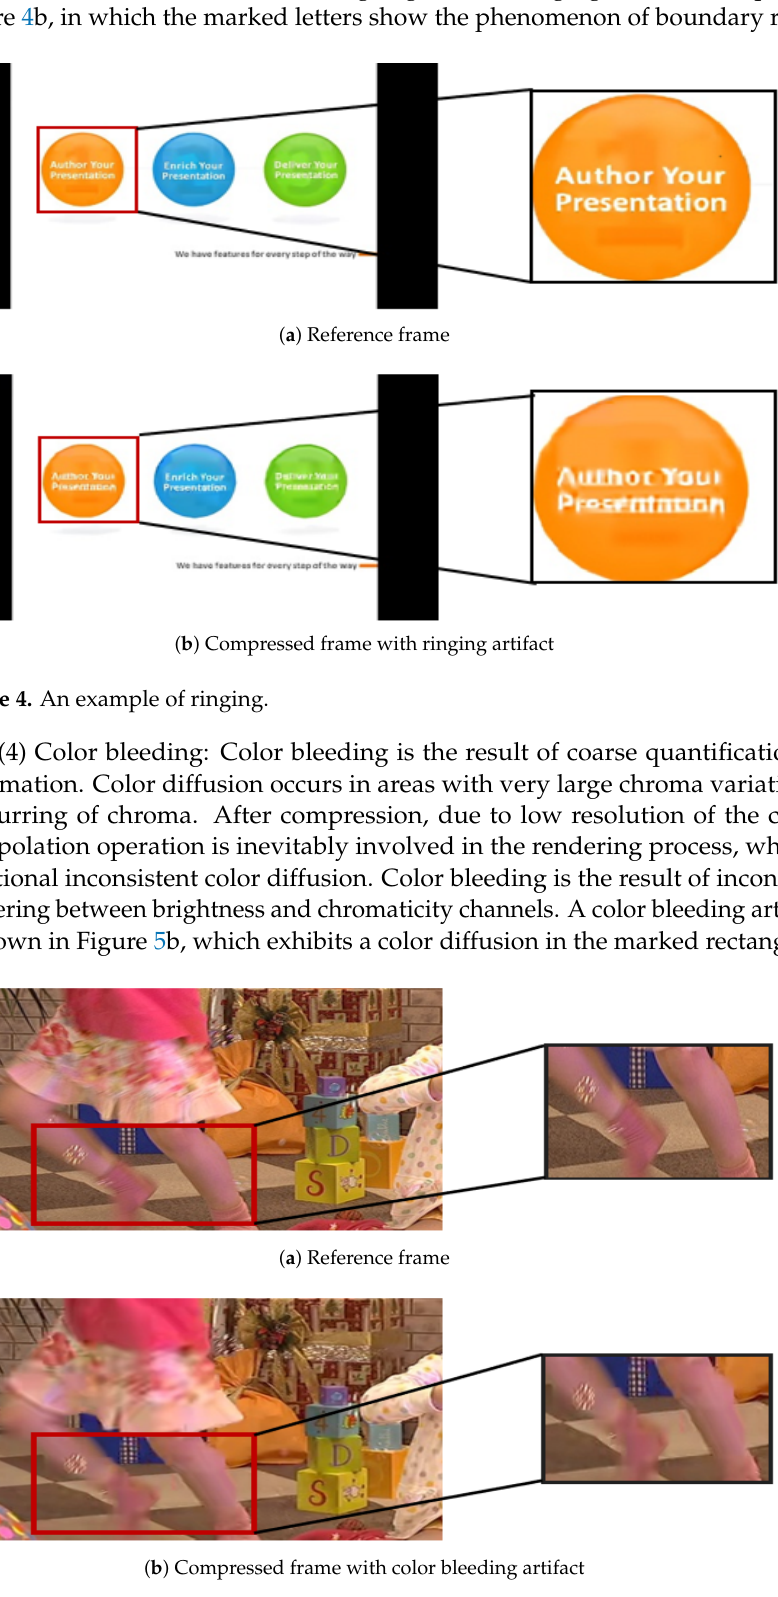
Figure 5. An example of color